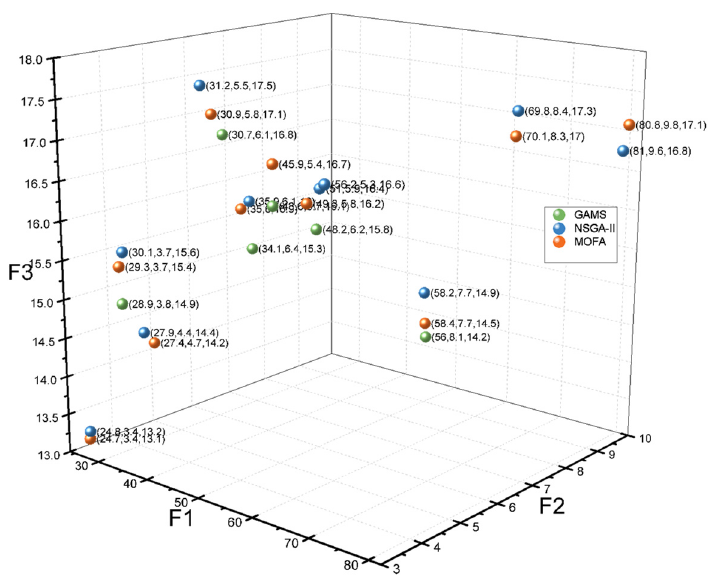
Figure 6. The best values of the augmented ε -constraint method, NSGA-II and MOFA.